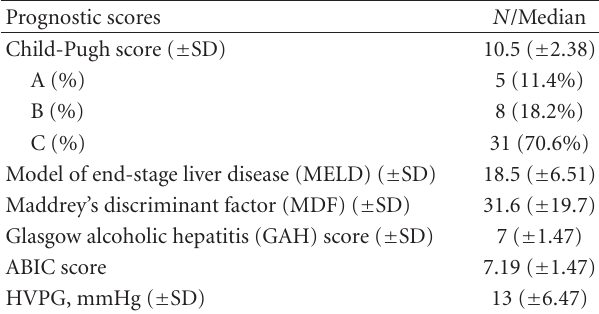
Table 3: Prognostic scores of 44 patients with histological evidence of AH at the time of